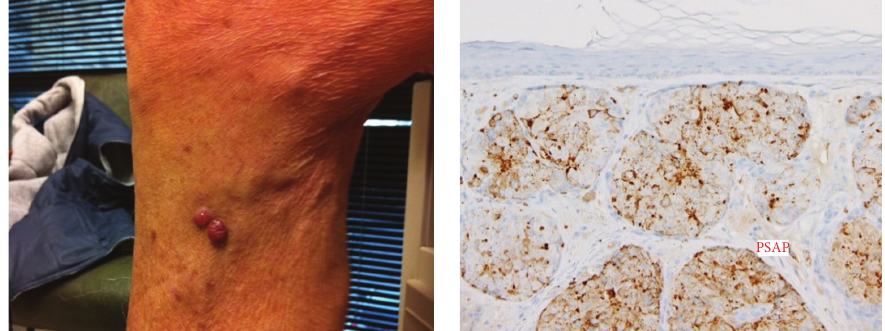
Figure 1: Gross image of cutaneous metastasis and histology of shave biopsy, strongly positive throughout the cytoplasm for PSAP.